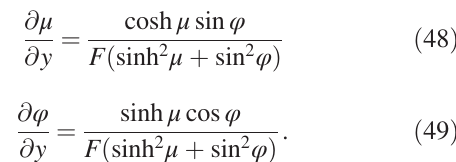
FIG. 9. Transverse indirect space charge per unit of length for b ¼ 0 . 35 cm and β ¼ 0 . 9 as a function of frequency for different q ¼ ð a − b Þ = ð a þ b Þ compared with the circular and flat beam r pipe given by IW2D, and with theory which uses the Laslett coefficients at low